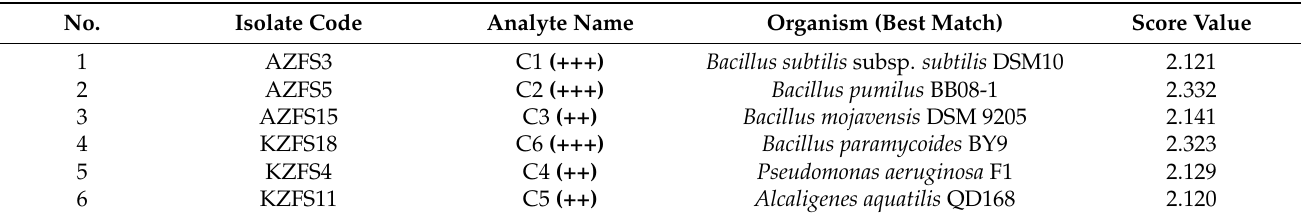
Table 3. Classification results are rated to Bruker Daltonik MALDI Biotyper.